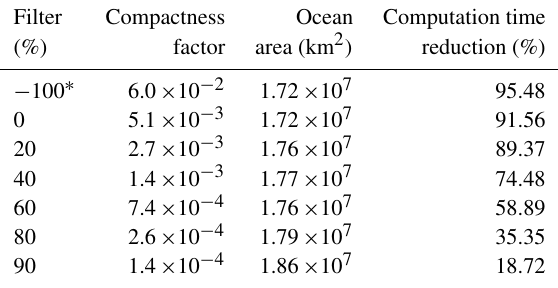
Figure 4. Land–ocean mask for the same region, with the topog- raphy passed through a high-pass filter. (a) 40% reduction in am- plitude for wavelengths above 30km. (b) 60% reduction. (c) 80% reduction. (d) 90% reduction. The ocean area increases slightly and the length of the coastline increases strongly. Table 4. Reduction in computation time for the 40, 5 and 1km res- olution scheme with respect to the 1km benchmark experiment for different bedrock topographies. Also listed are the area and com- pactness factor of the resulting ocean